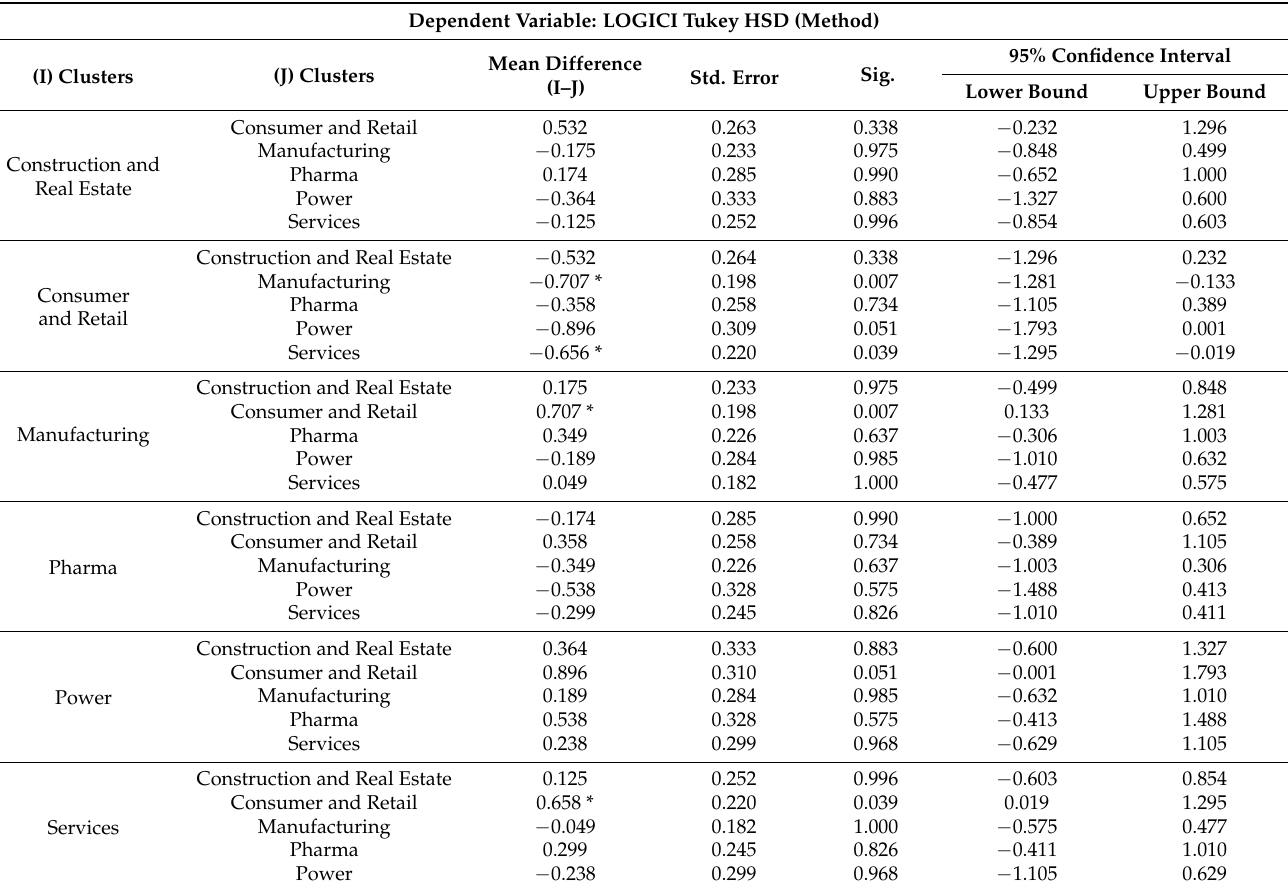
Table 6. Post-hoc tests: Multiple